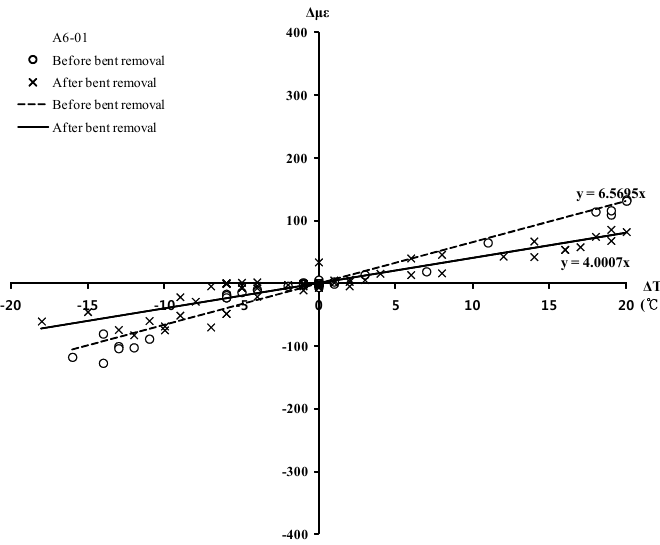
Figure 12. Change in thermal coefficient ( R ) of